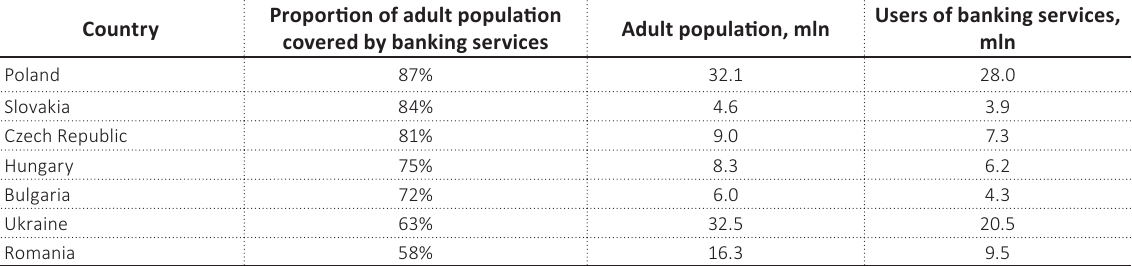
Table 2. Coverage of the population by banking services: Selected CEECs in